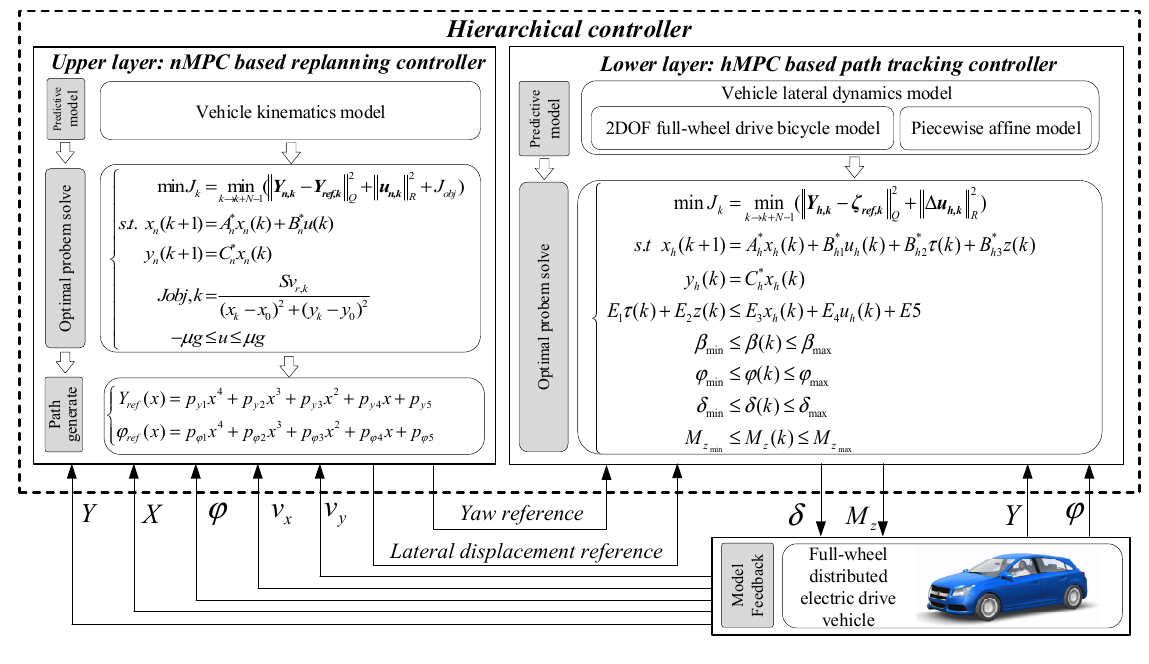
Figure 6. The hierarchical control scheme.